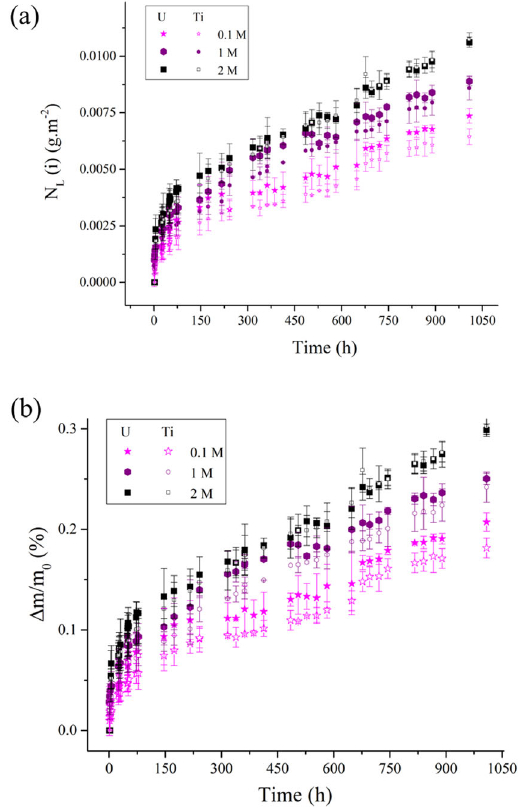
Fig. 5 Dissolution of brannerite in H 2 SO 4 solutions at 25 °C. Evolution of the normalized weight losses N L (i) (g/m 2 ) ( a ) and of the relative mass losses Δ m i / m 0 (%) ( b ) obtained during the dissolution of synthetic brannerite samples in various H 2 SO 4 solutions at 25